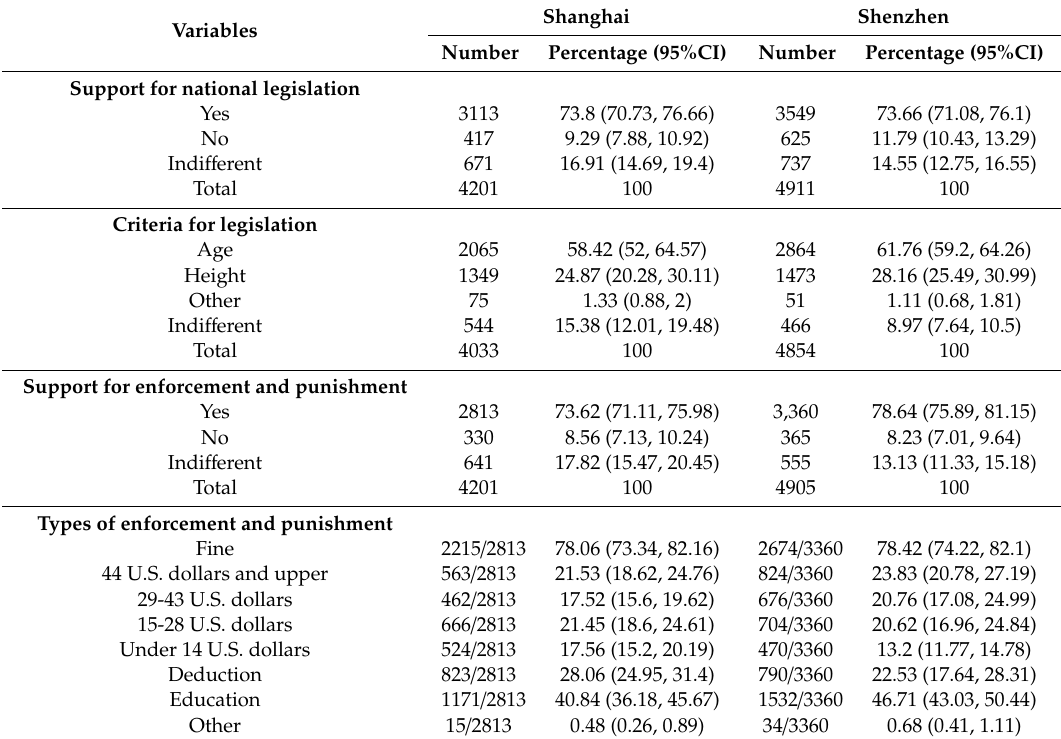
Table 3. Support of national legislation in the two cities.